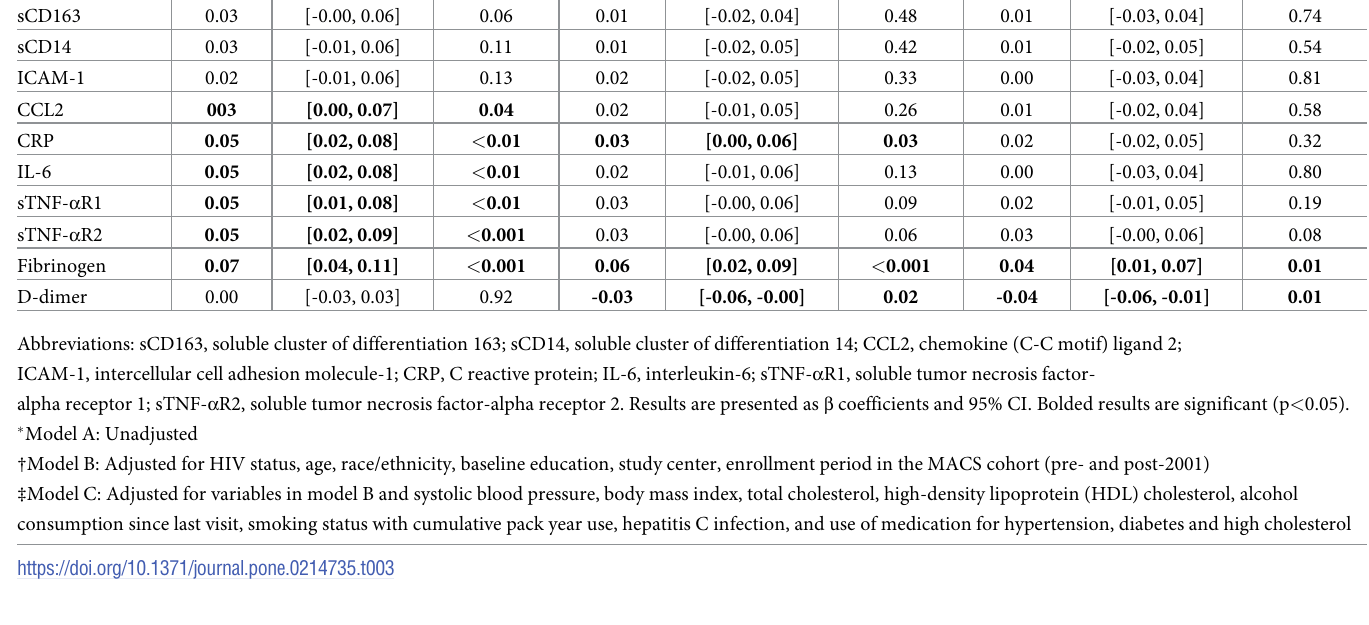
Table 3. Associations between inflammatory biomarkers and intima media thickness of the right common carotid artery (CCA-IMT) (N = 728). Biomarkers